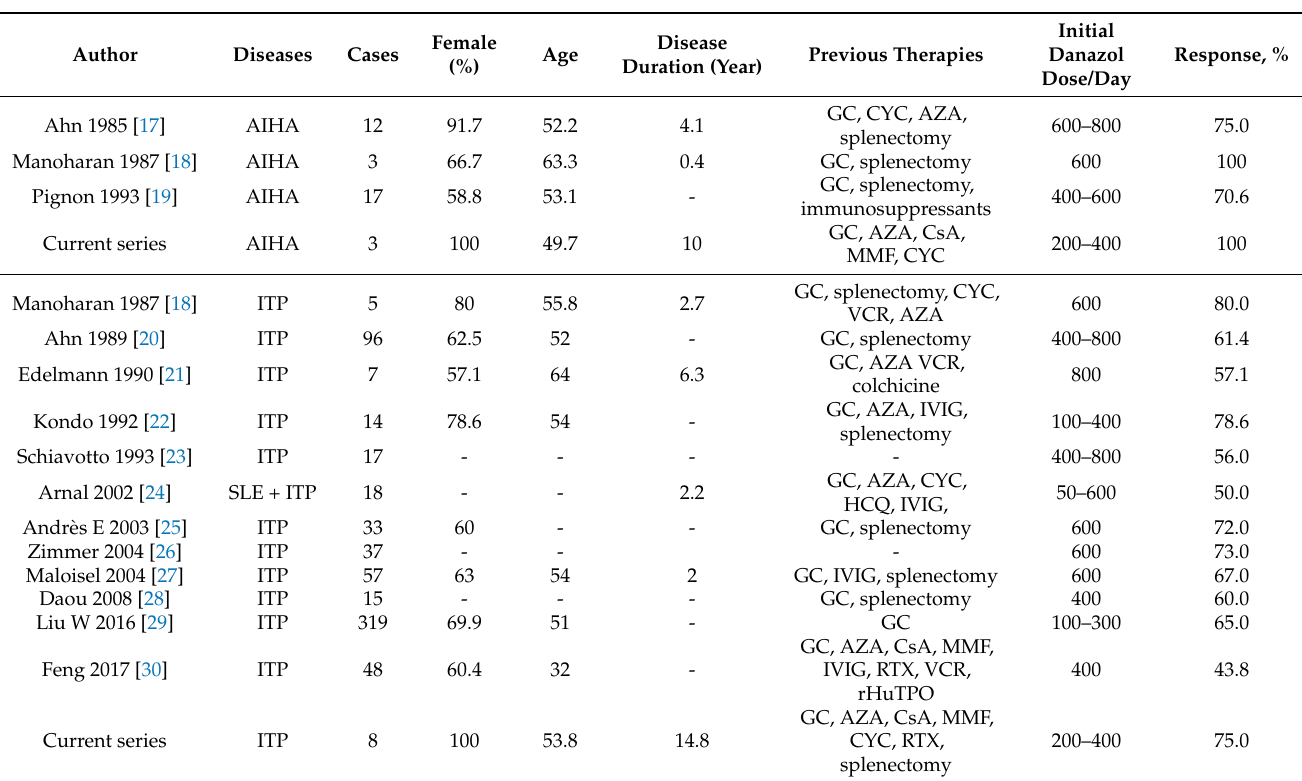
Table 2. Published studies on danazol for the treatment of immune thrombocytopenia and autoim- mune hemolytic